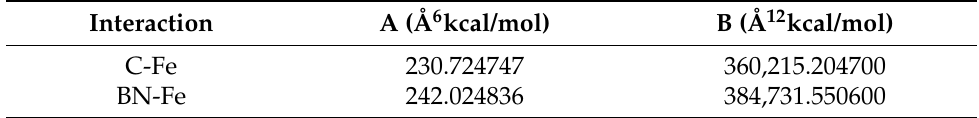
Figure 1. Schematic illustration of a Fe atom interacting with nanotube: ( a ) entering a nanotube and ( b ) inside a nanotube. Table 1. Approximate values of the attractive and repulsive